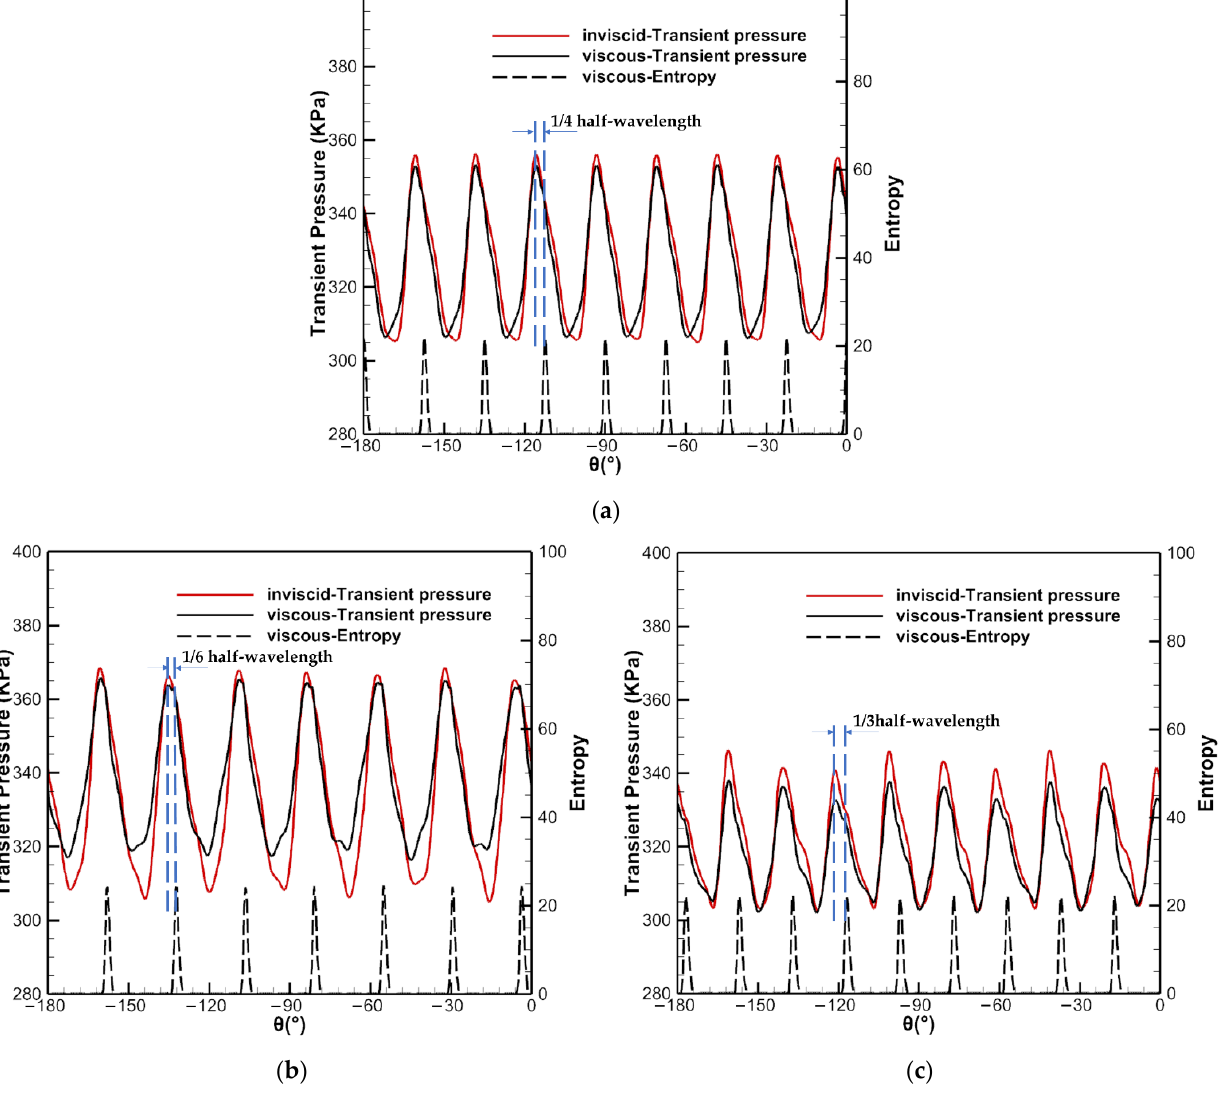
Figure 16. Circumferential distribution of the transient pressure and entropy for different cases, where the ratio of vane counts to rotor blade counts was: ( a ) 16:48; ( b ) 14:48; ( c ) 18:48.